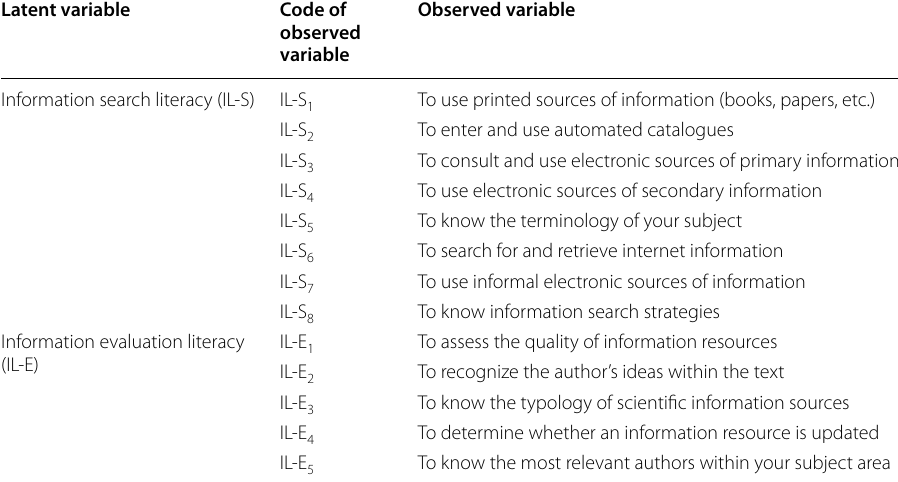
Table 2 Latent variables in perceived information literacy: information search literacy (IL-S) and information evaluation literacy